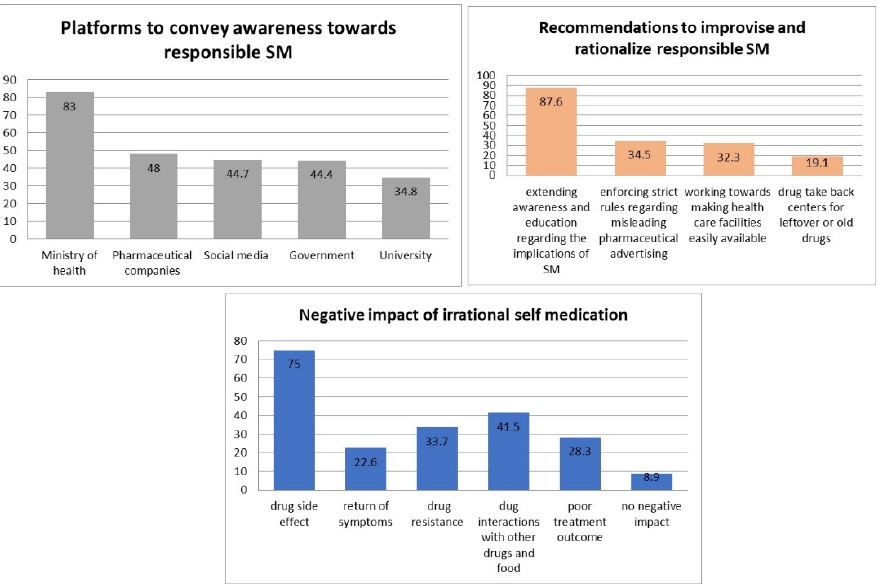
Figure 4. The negative impact of irrational SM, awareness, recommendations to improvise and rationalize responsible SM.